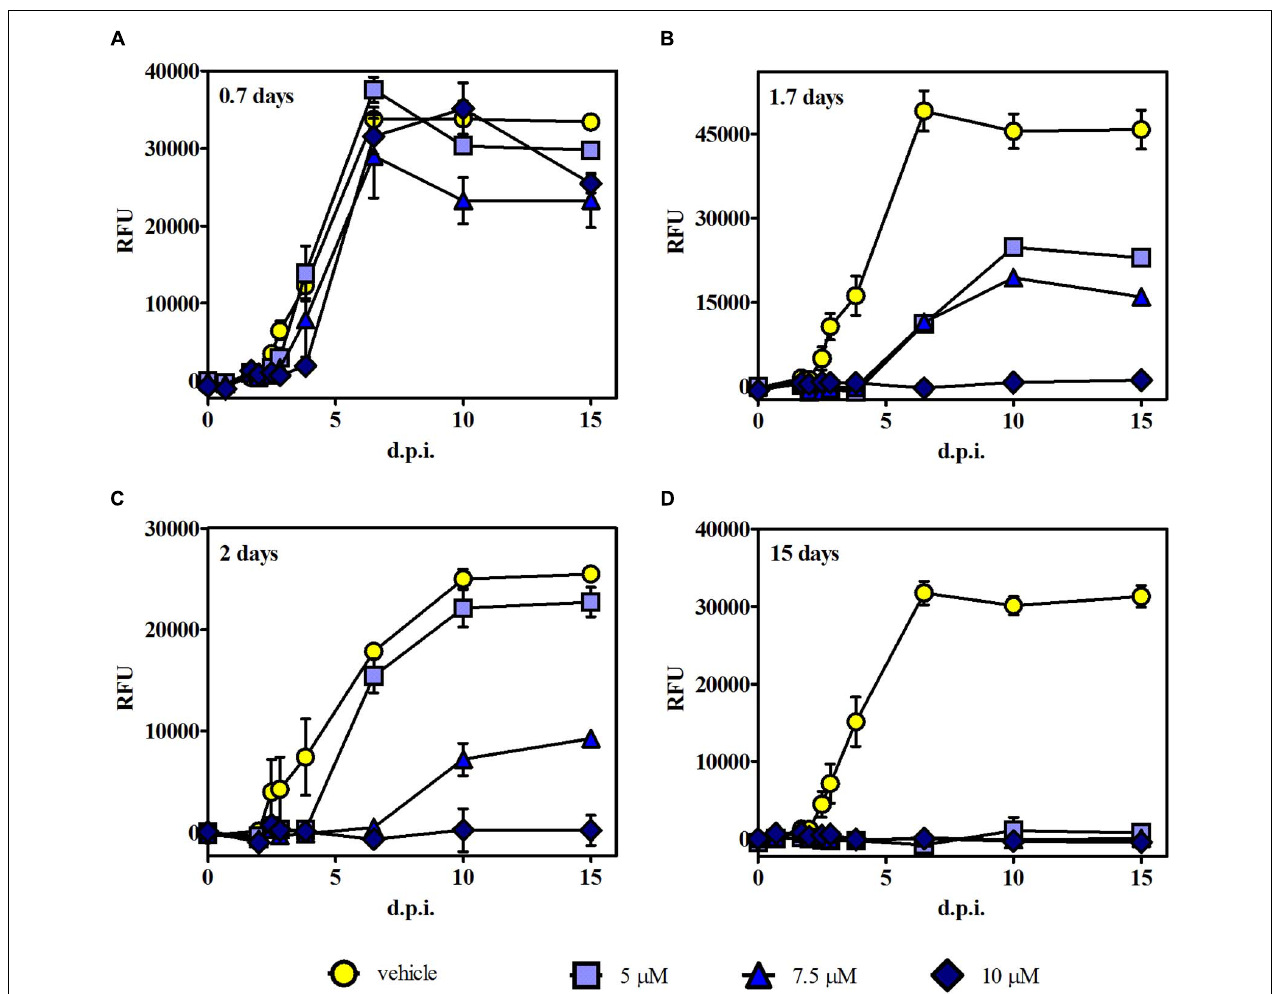
FIGURE 5 | Time of removal assays. Intracellular tachyzoites (RH RFP strain) were cultured in the presence of 5, 7.5, and 10 µ M of 3 or the vehicle, and after (A) 0.7, (B) 1.7, and (C) 2 days of treatment, the medium was changed. Parasite growth was monitored by fluorescence emission measurements in the absence of the compound at different times up to 15 d.p.i. (D) The compound was present during the whole assay. Results are means (triplicates) of RFU ±